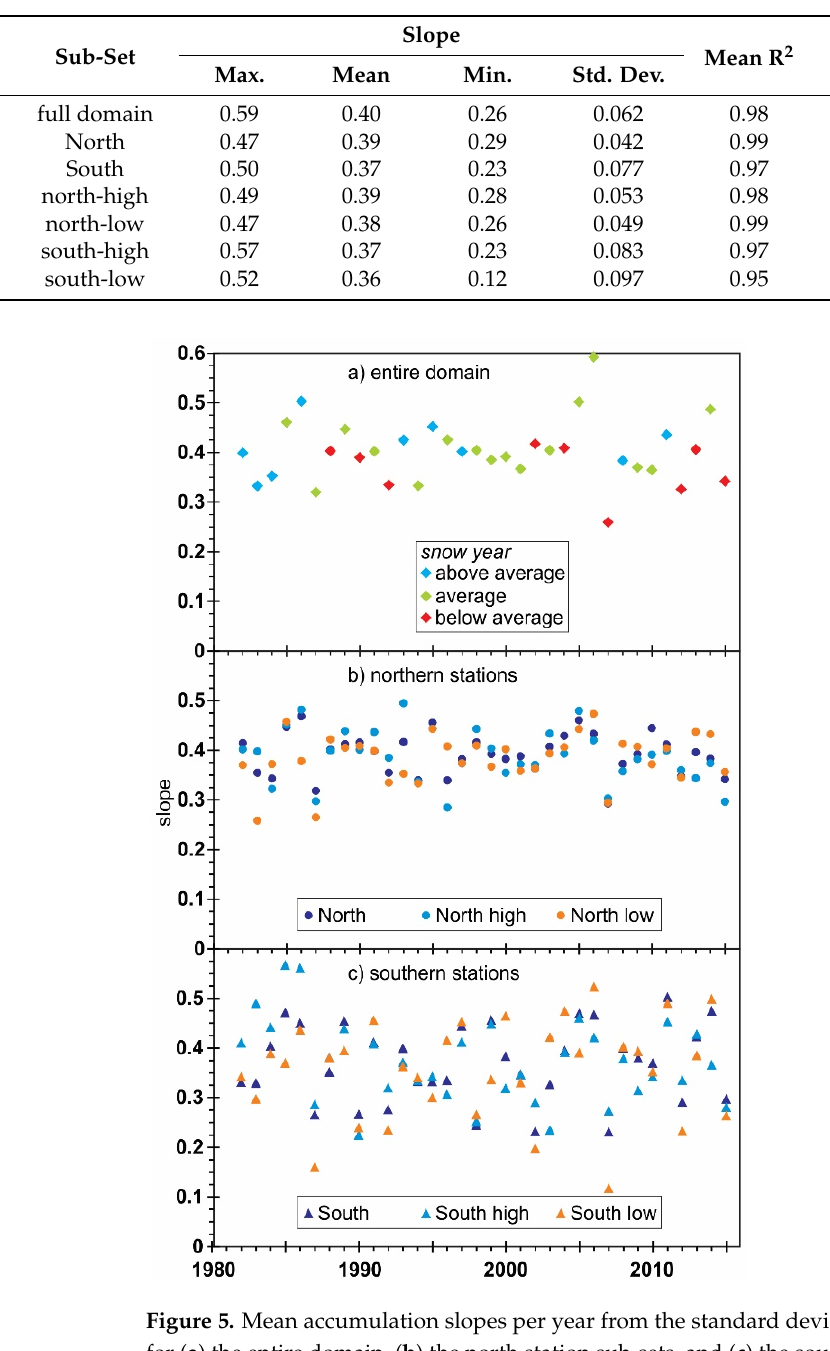
Table 3. Full domain and six sub-sets summary of accumulation phase slope statistics (maximum, mean, minimum, standard deviation) plus the mean R 2 of all truncated linear fits over the entire 34-year period of analysis, and mean slope for above average (AA), average (AVG), and below average (BA) snow years. See Figure 5 for specific years.